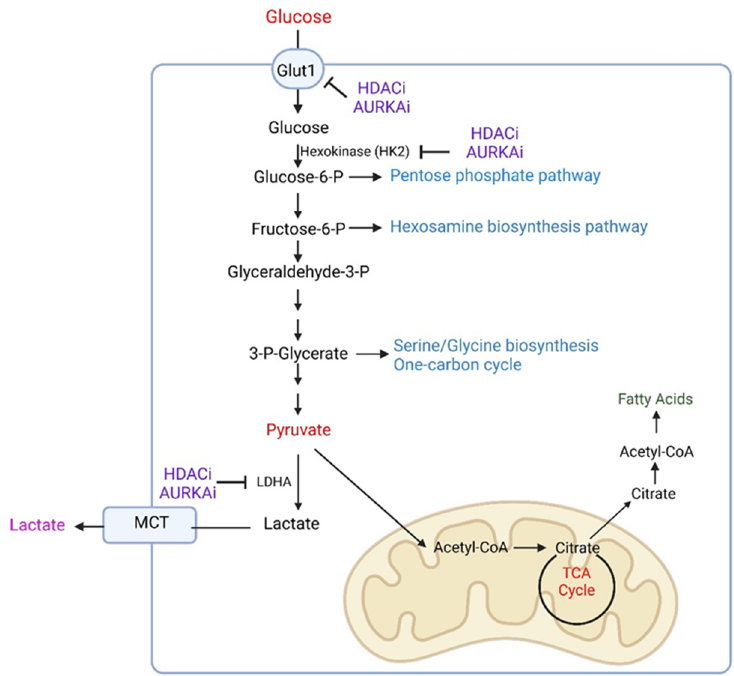
Figure 1. Glycolysis and related pathways in GBM cells. Glucose enters GBM cells via GLUT1 in a manner independent of insulin. Upon entry, glucose is phosphorylated to glucose-6-phosphate and may be processed further in the pentose phosphate pathway or in glycolysis. Glycolysis feeds and communicates with the hexosamine biosynthesis pathway (at the level of fructose-6-phosphate) as well as the serine/glycine pathway (originating from 3-phospho-glycerate). The final product of glycolysis is pyruvate, which may subsequently convert to lactate, resulting in regeneration of NADH to NAD, facilitating rapid glycolytic flux. Lactate is removed from the cell through either MCT1 or MCT4. Alternatively, pyruvate is converted to acetyl-CoA, which in turn reacts to citrate. Citrate may be either processed in the TCA-cycle or used to give rise to cytosolic acetyl-CoA, which is used for fatty acid synthesis. HDAC and aurora kinase A inhibitors block glycolysis by suppression of GLUT1, hexokinase II, and LDHA.